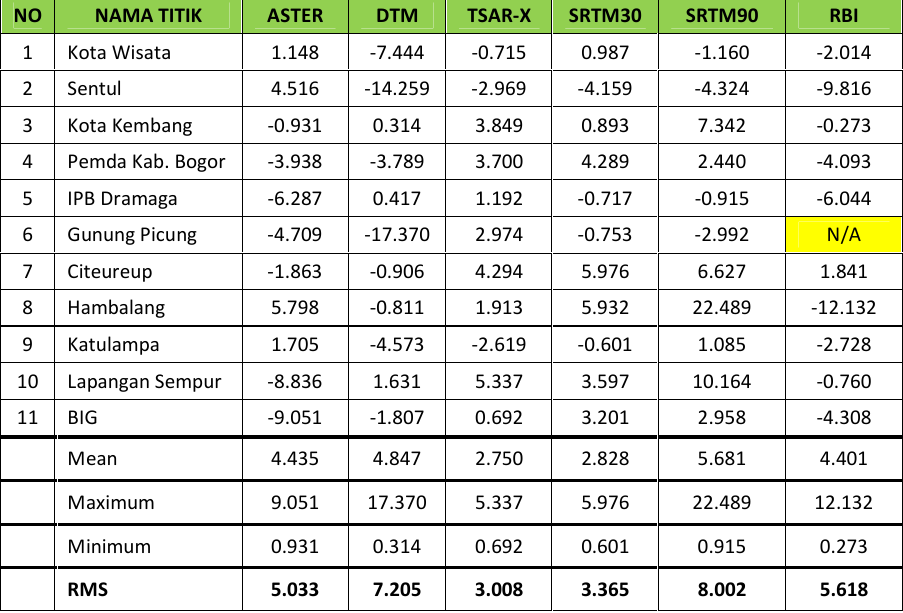
Table 6. Height-differences of Z-value in each DEM to the GPS meausred test